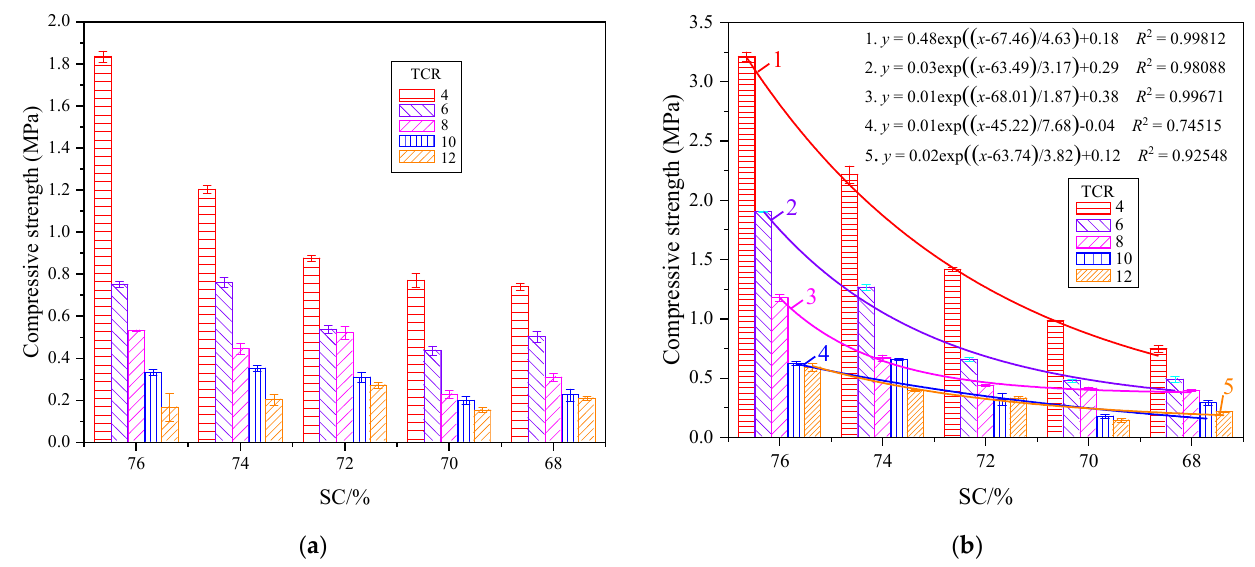
Figure 3. Compressive strength of CSTB at different SCs with curing age of 3 d ( a ) and 7 d ( b ). Under the same TCR, the CSTB intensities of different SCs were fitted. When the cur- ing age was 3 days, except for the fitting curve of TCR = 4, the appropriate effect of the strengths of different SCs under the other TCRs was not noticeable. This is because, with the increase in TCR, the 3-day strength decreases with the decrease in SC. However, when